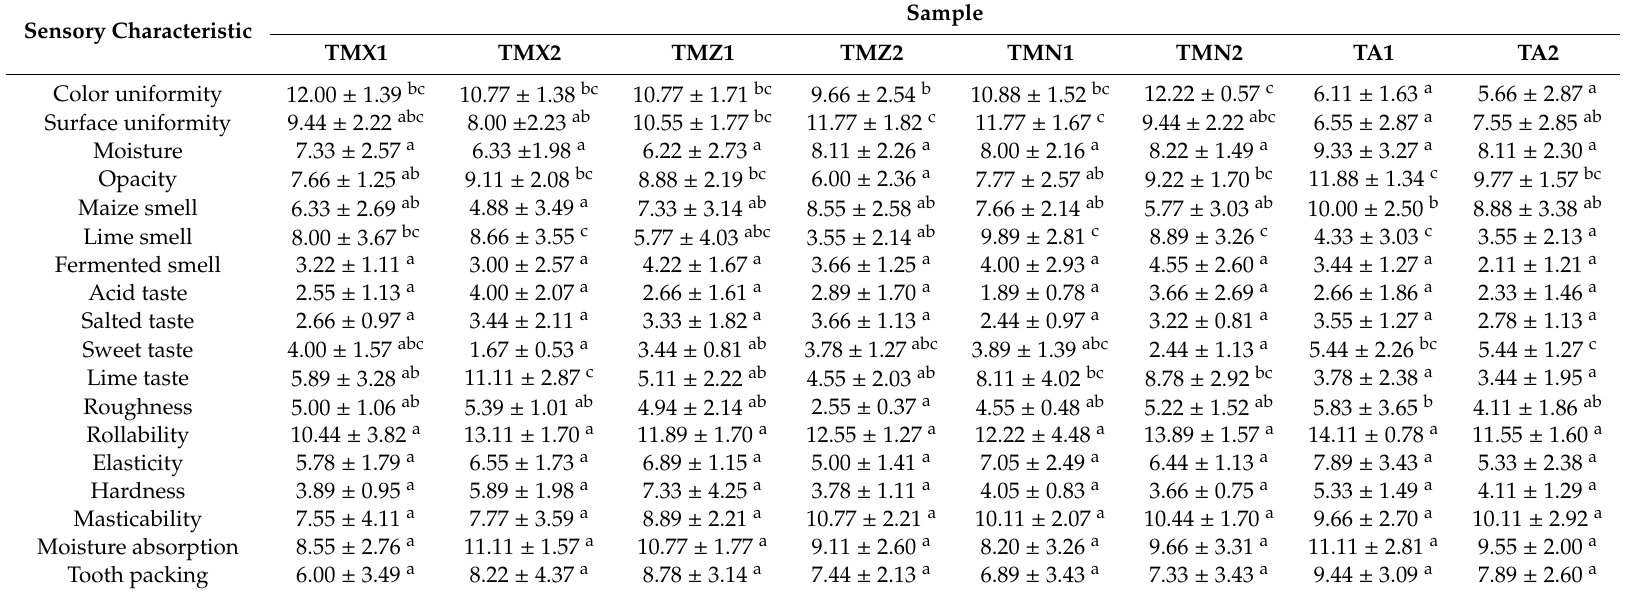
Table 5. Sensory and subjective textural parameters of tortilla